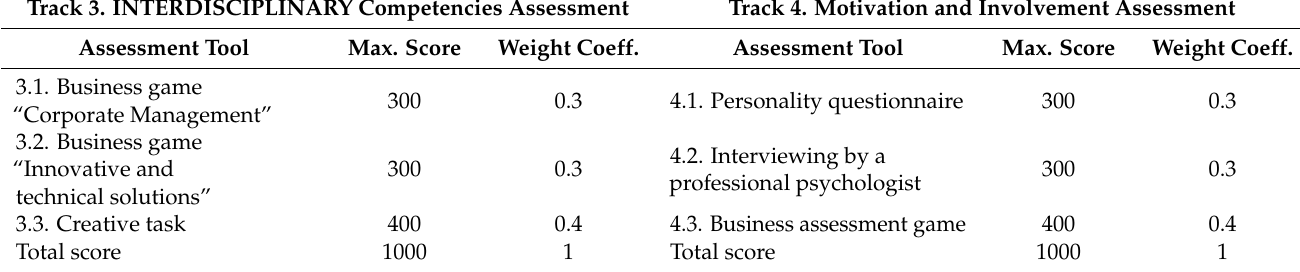
Table 4. Assessment of human capital components (Track 3, Track 4).